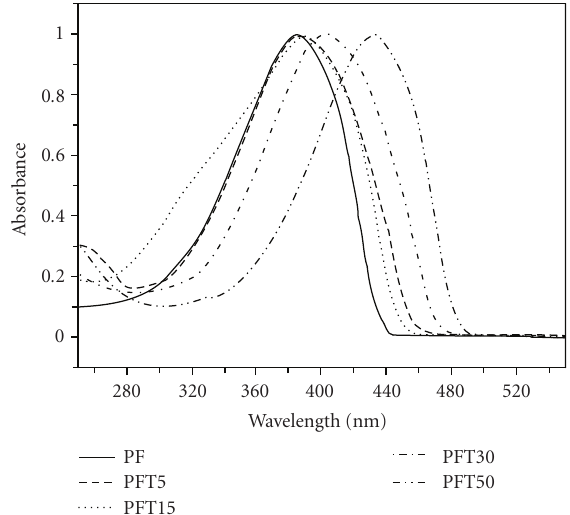
Figure 2: UV-Vis spectra of the di ff erent